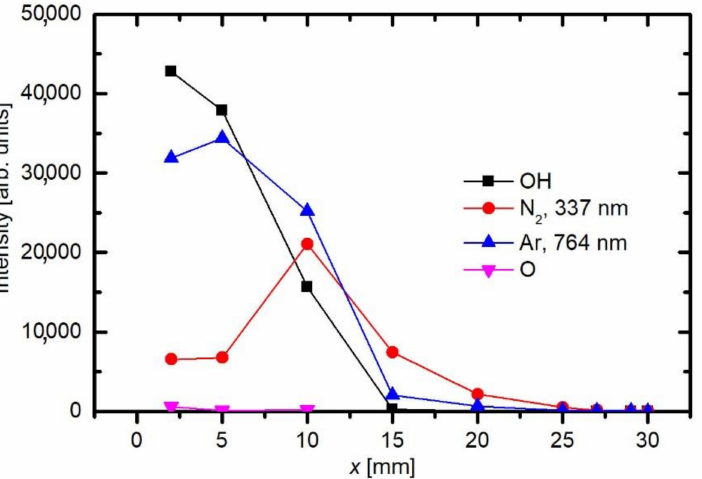
Figure 4. The axial distribution of the major OES spectral features versus the distance from the exit of the discharge tube.